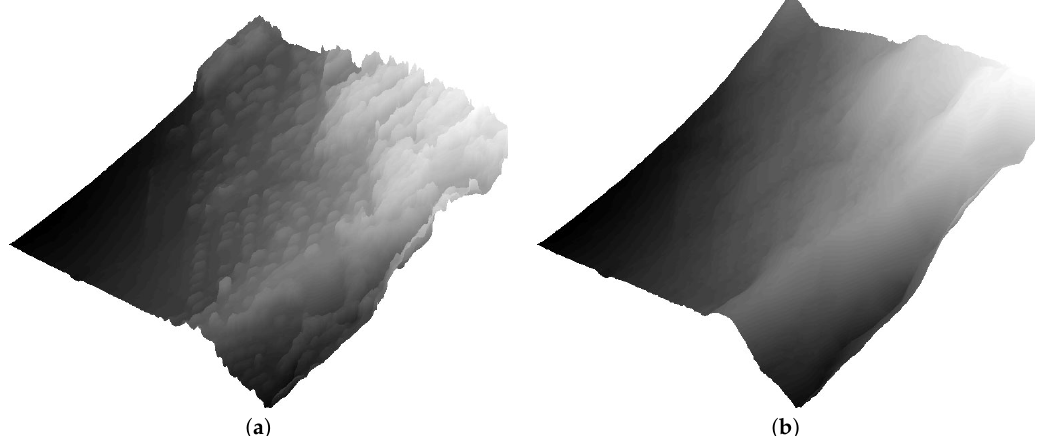
Figure 27. 3D view of ( a ) the DSM as shown in Figure 26 and ( b ) the resulting DTM after applying the proposed filtering